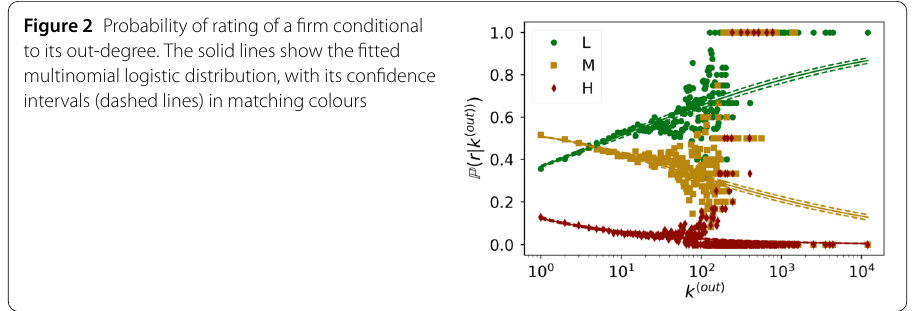
Figure 2 Probability of rating of a firm conditional to its out-degree. The solid lines show the fitted multinomial logistic distribution, with its confidence intervals (dashed lines) in matching